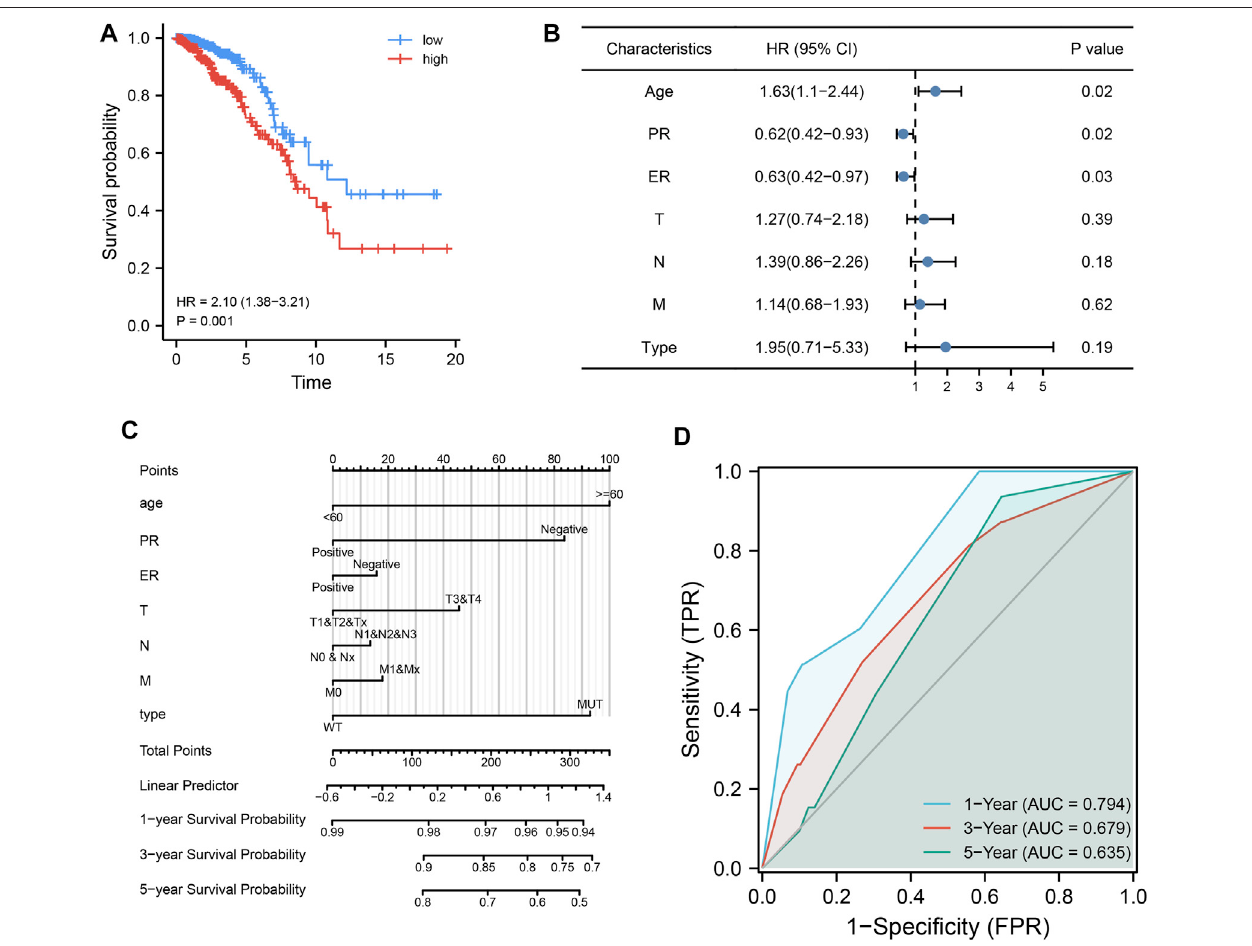
FIGURE8| EffectofMDN1genemutationontheclinicalprognosisinTCGA-BRCAdataset. (A) Coxregressionanalysisshowedthattheprognosisofpatientswith BRCA in the high-risk group was signi fi cantly worse ( p = 0.001); (B) Forest plot showing the effect of univariate analysis of MDN1 gene mutations and different clinicopathological features on OS of patients; (C) MDN1 mutation combined with clinicopathological features to construct nomogram; (D) ROC curves for the model with area under the curve (AUC) of 0.794, 0.679, and 0.635 at 1, 3, and 5 years, respectively.